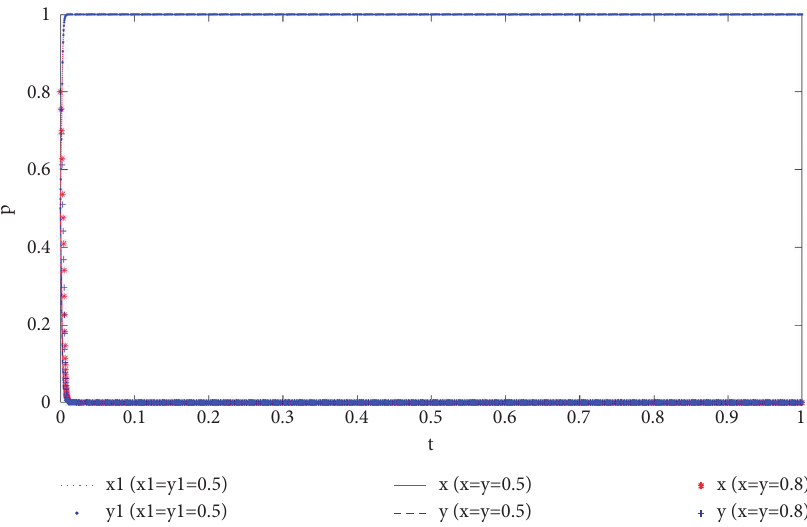
Figure 6: Influence of standardization degree on evolution results of two game systems.